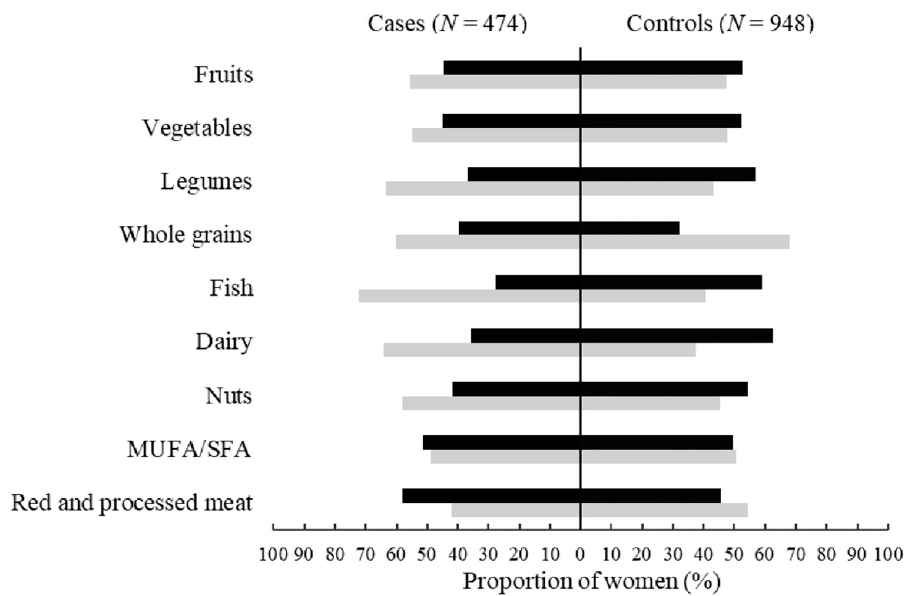
Figure 1. The proportion of women consuming food components in the Mediterranean Diet Score during pregnancy by the median intake levels among cases and controls. MUFA/SFA, monounsaturated-to-saturated fat ratio. Dark shaded bars indicate maternal consumption above the median levels, and light shaded bars indicate maternal consumption equal to or below the median levels. Statistically significant differences were found for the groups of fruits, vegetables, legumes, fish, dairy, nuts, and red and processed meat between cases and controls by the χ 2 test (all p <